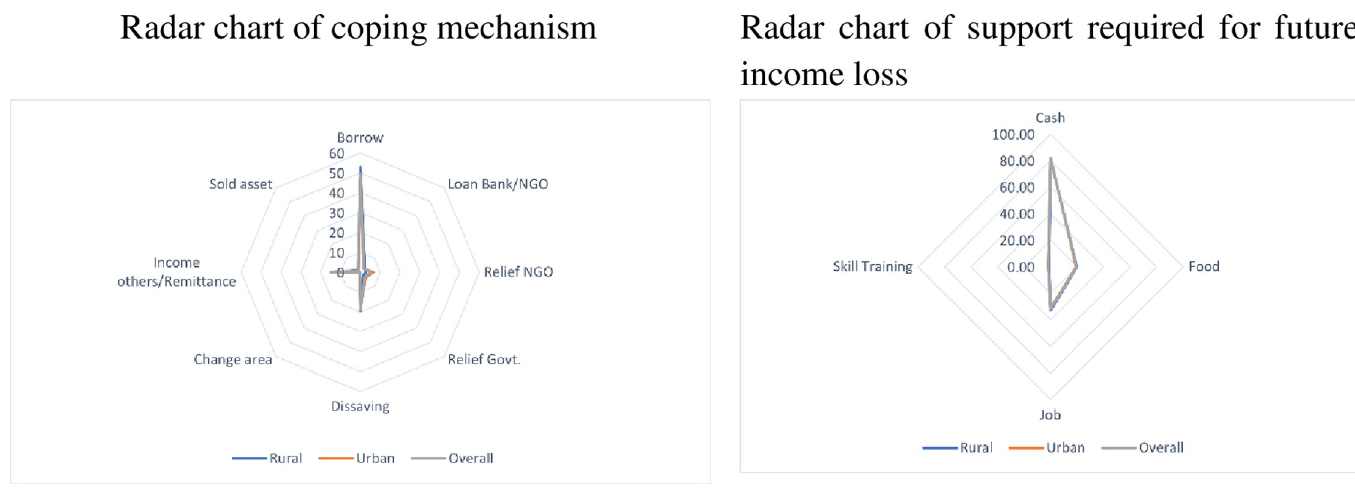
Fig 6. Coping mechanism for current shock and support required for future shock of informal workers.